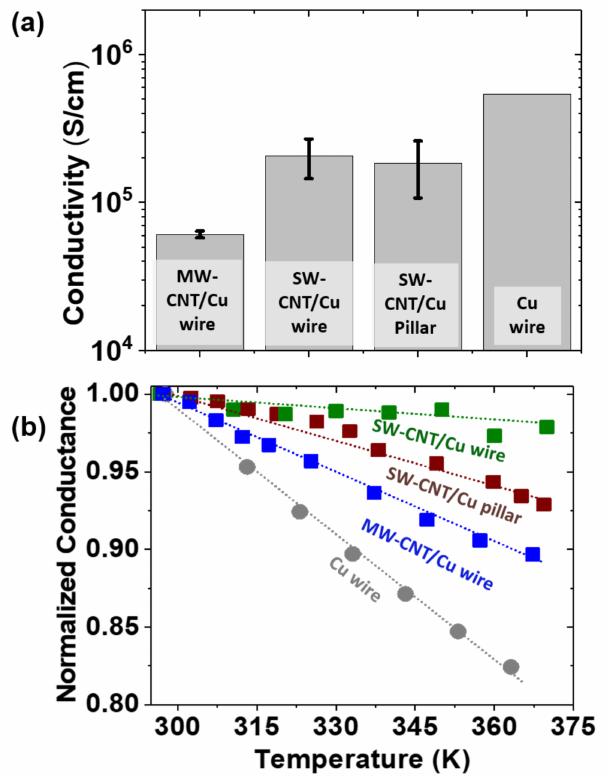
Figure 4. Electrical performances of CNT/Cu composites: ( a ) room-temperature electrical conductiv- ities and ( b ) normalized conductance (to room-temperature conductance) vs. temperature